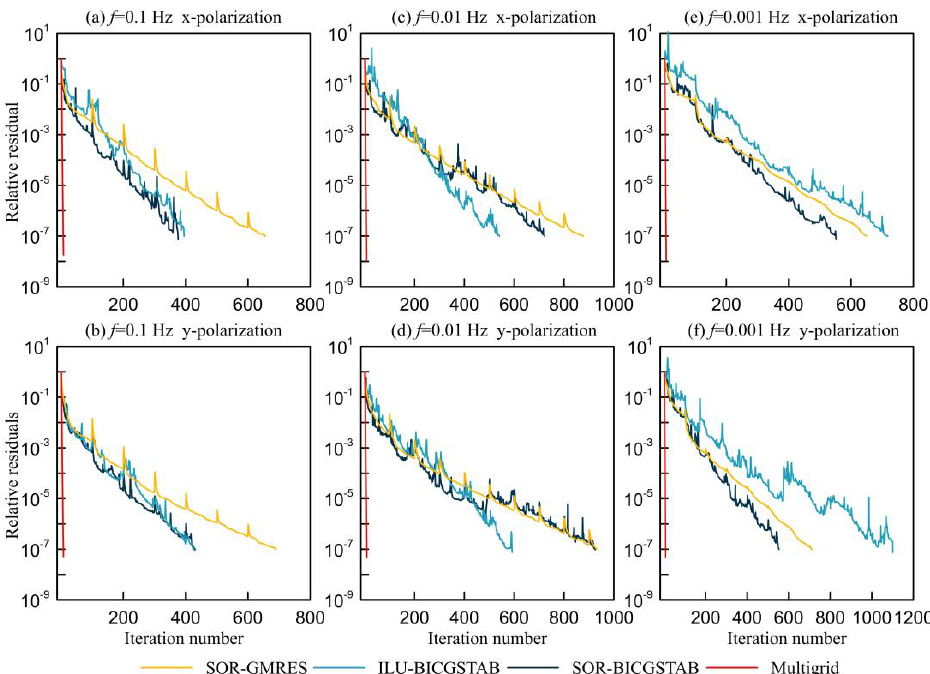
Figure 12. Convergence curves of SOR-GMRES, ILU-BICGSTAB, SOR-BICGSTAB and our MG algorithm for DTM1 model at 0.1, 0.01 and 0.001 Hz. The computation is conducted on the grid of size 128 × 128 × 64, with a DoF of 3,211,584. Table 3. Computational performance of SOR-GMRES, ILU-BICGSTAB, SOR-BICGSTAB and our